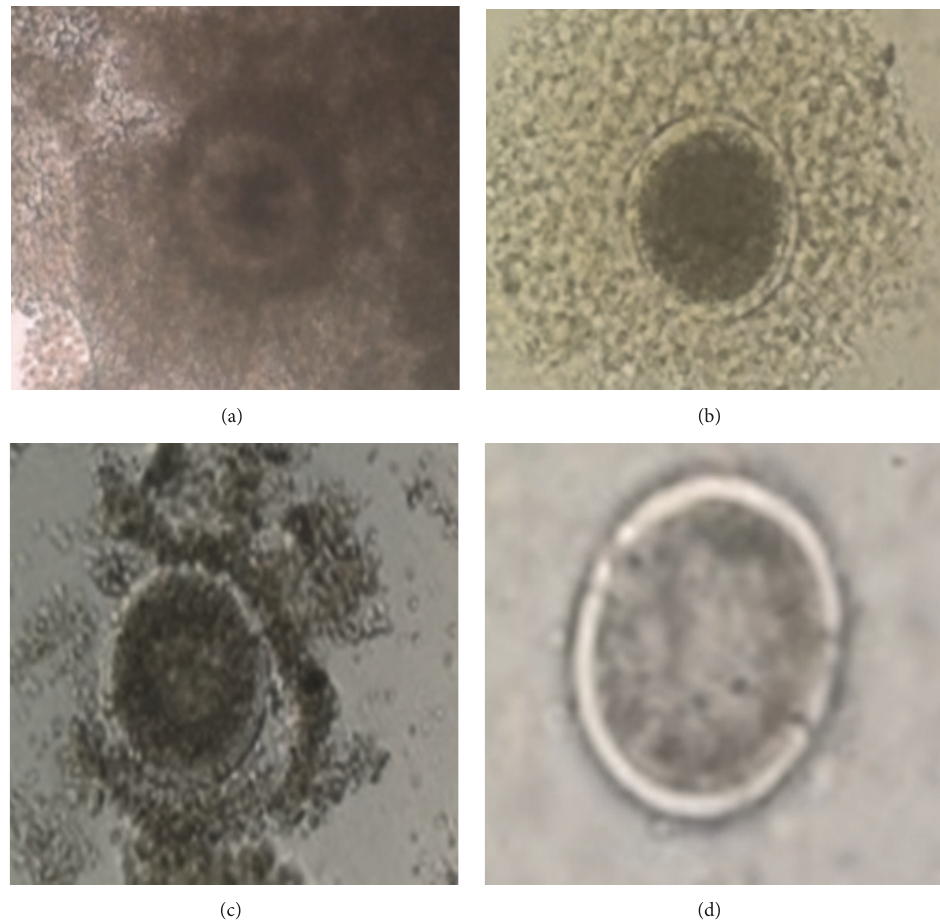
Figure 1: Oocytes: (a) Grade I, (b) Grade II, (c) Grade III, and (d) Grade